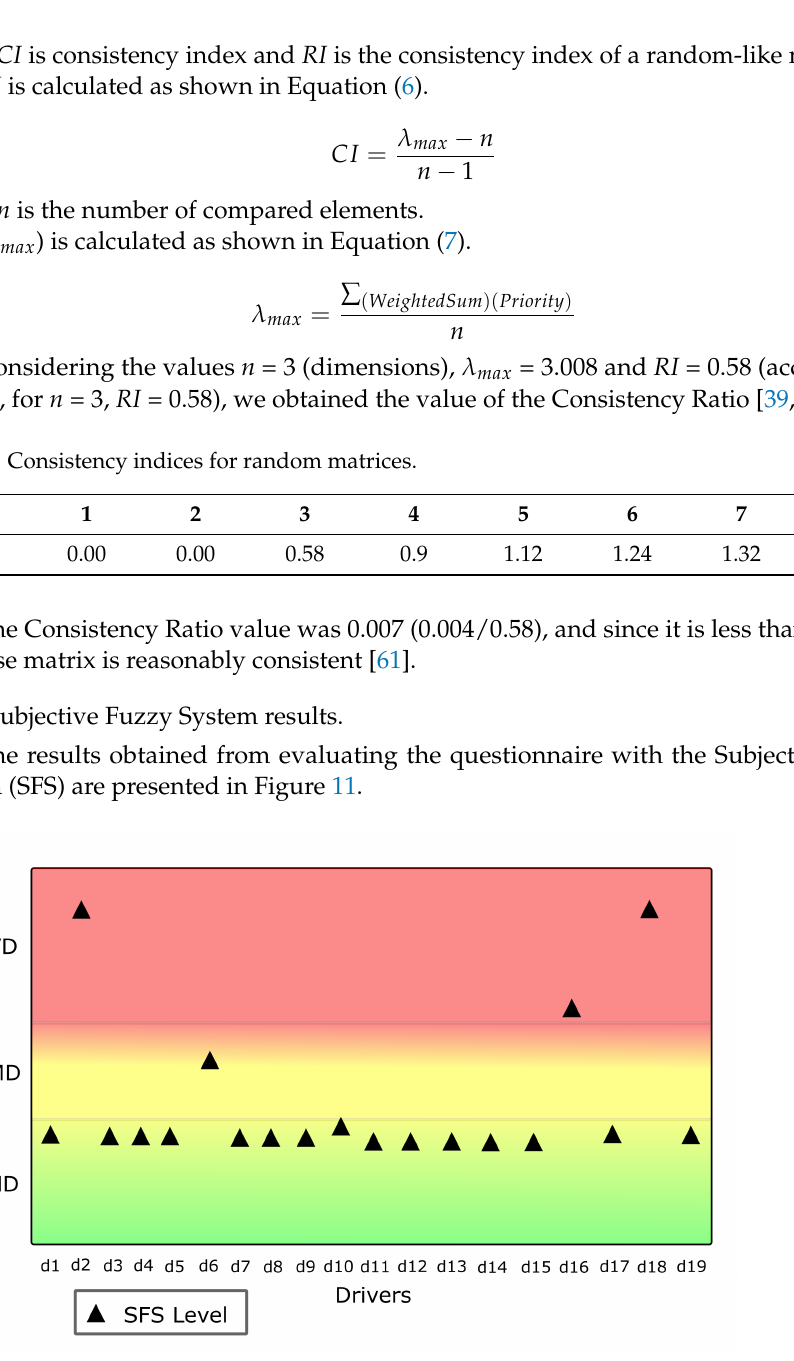
Figure 11. Subjective Fuzzy System (SFS)